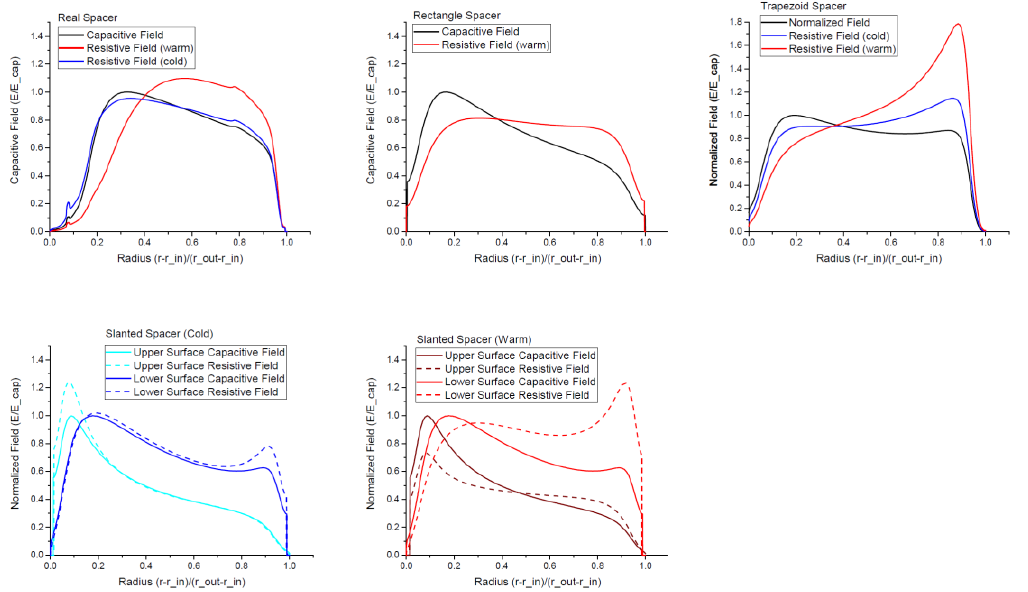
Figure 6. Resistive and capacitive electric field along the solid-gas interface for all considered geometries. The applied voltage is 100 kV [13].